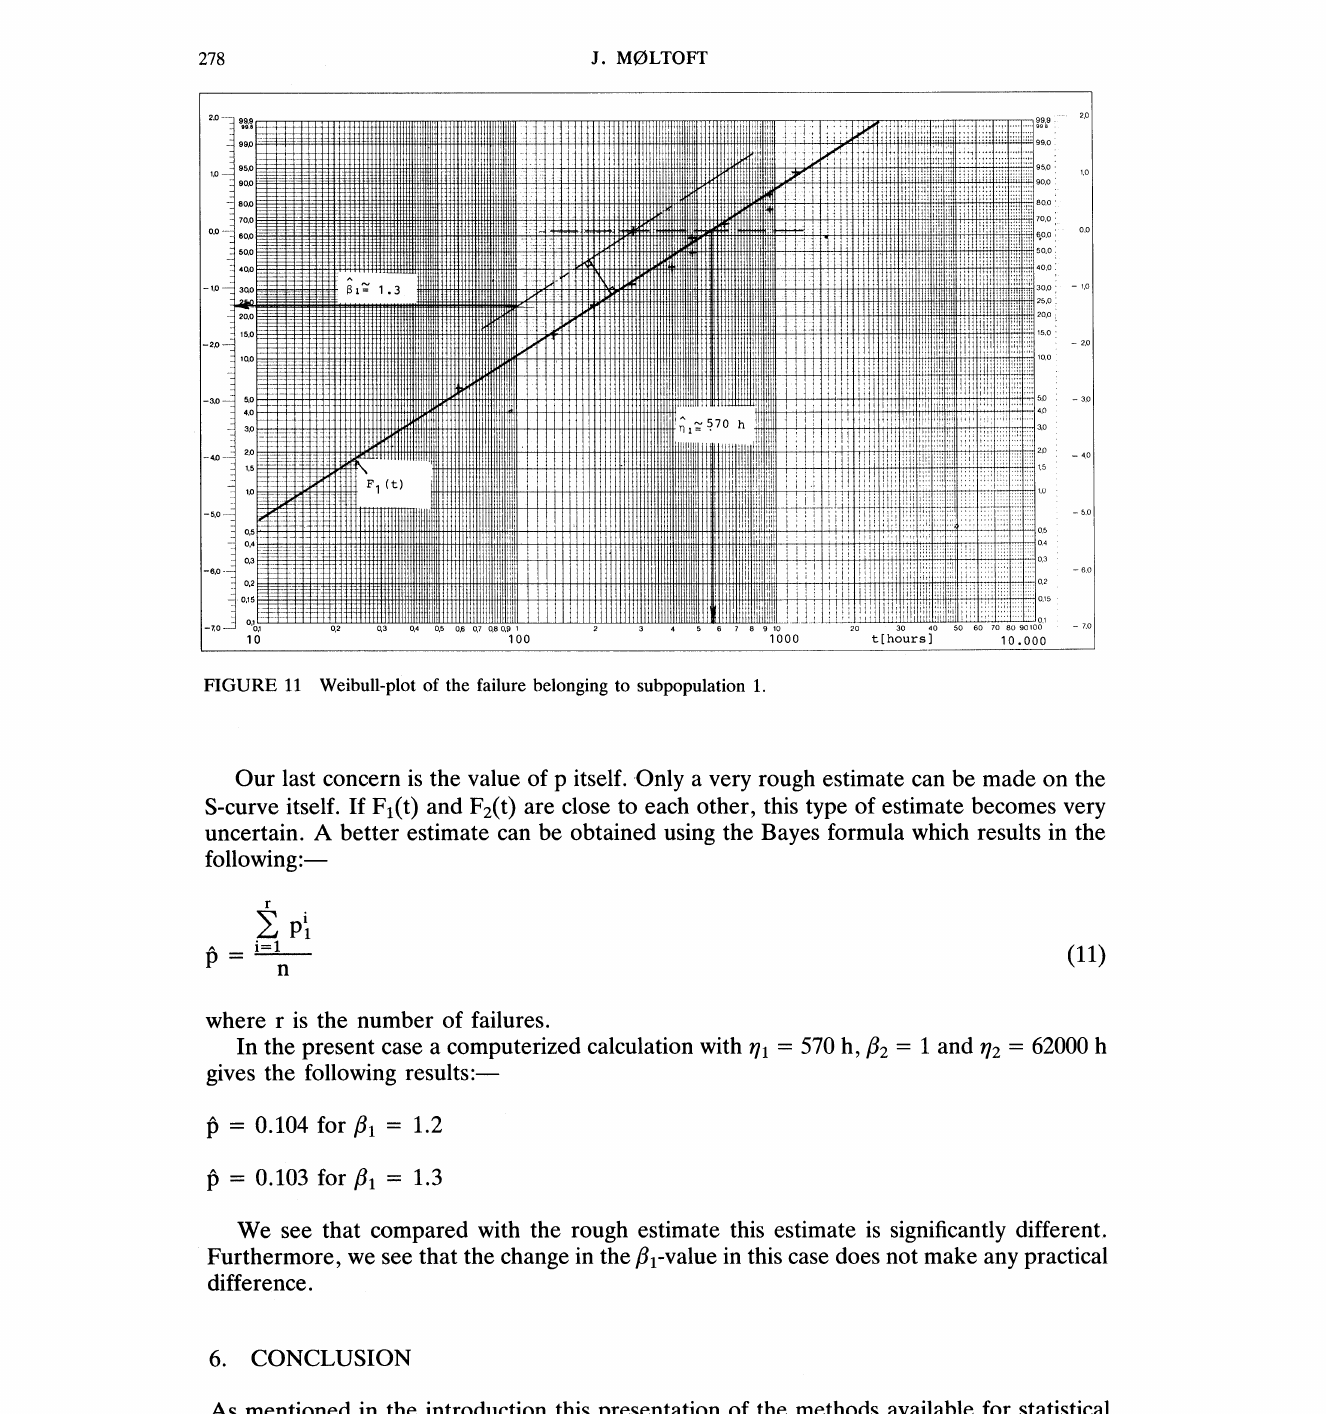
FIGURE 11 Weibull-plot of the failure belonging to subpopulation